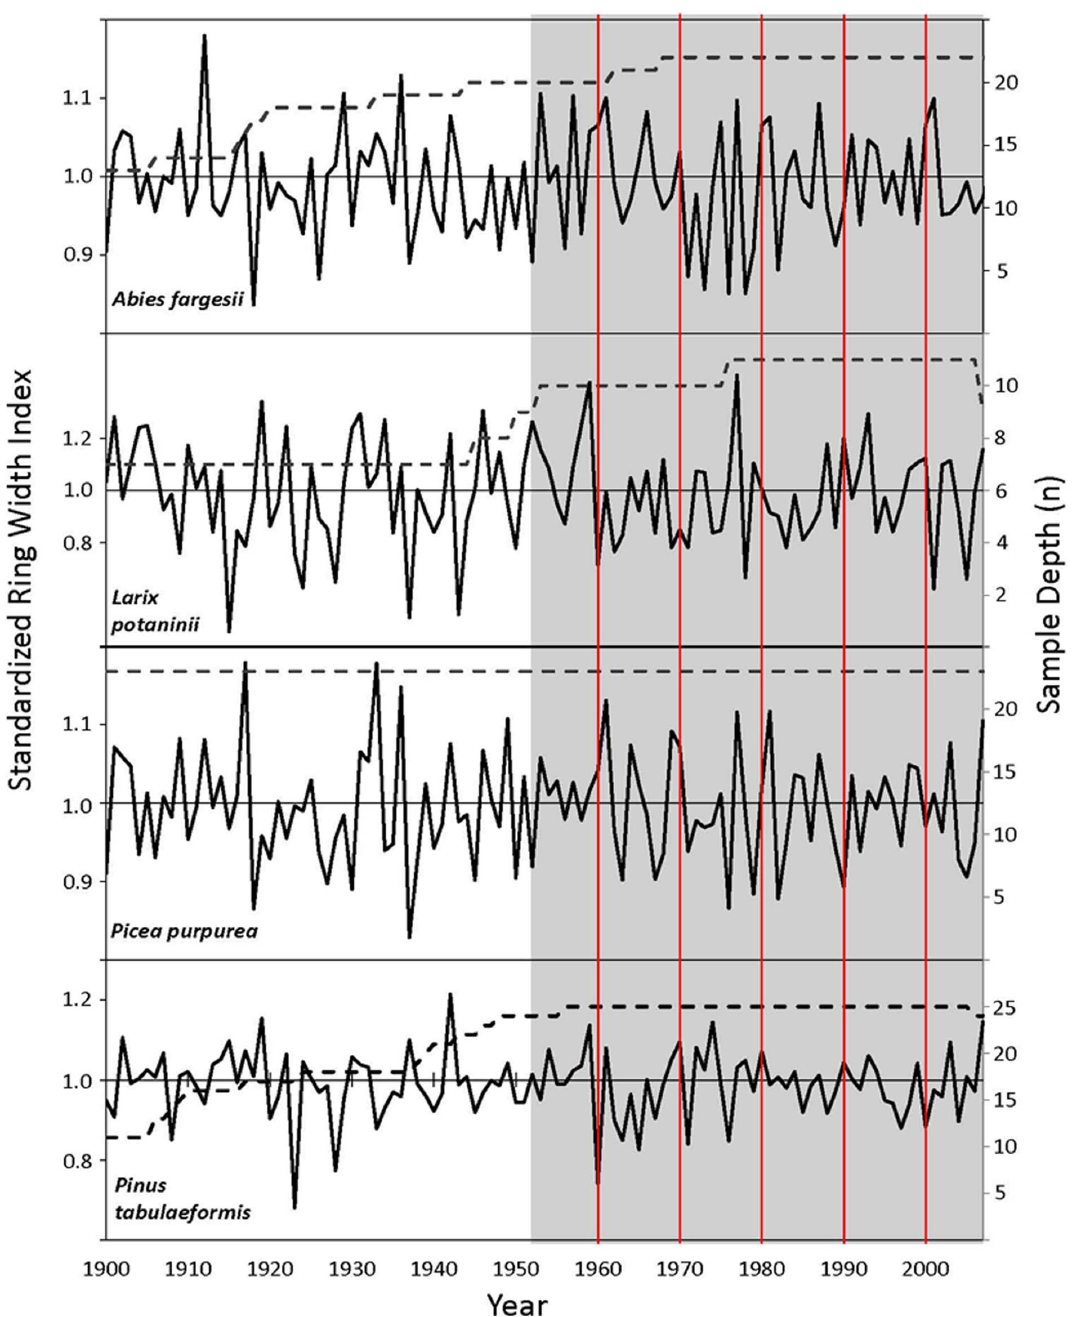
Figure 6. Standard tree-ring chronologies for four conifers of Jiuzhaigou National Nature Reserve. Chronologies span 1900–2007 for the four species ( Abies fargesii , Larix potaninii , Picea purpurea and Pinus tabuliformis ) used in dendroecological analysis. The ring width index is represented by the solid line (left axis) and sample depth by the dashed line (right axis). The period (1952–2007) analyzed for growth-climate correlation function is highlighted in grey. To facilitate alignment across species, four vertical lines are placed at 1960, 1970, 1980, 1990 and 2000. See Methods for more detail on how chronologies were built.